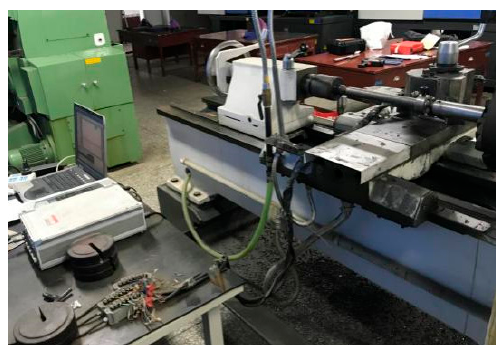
Figure 5. Measurement scene.